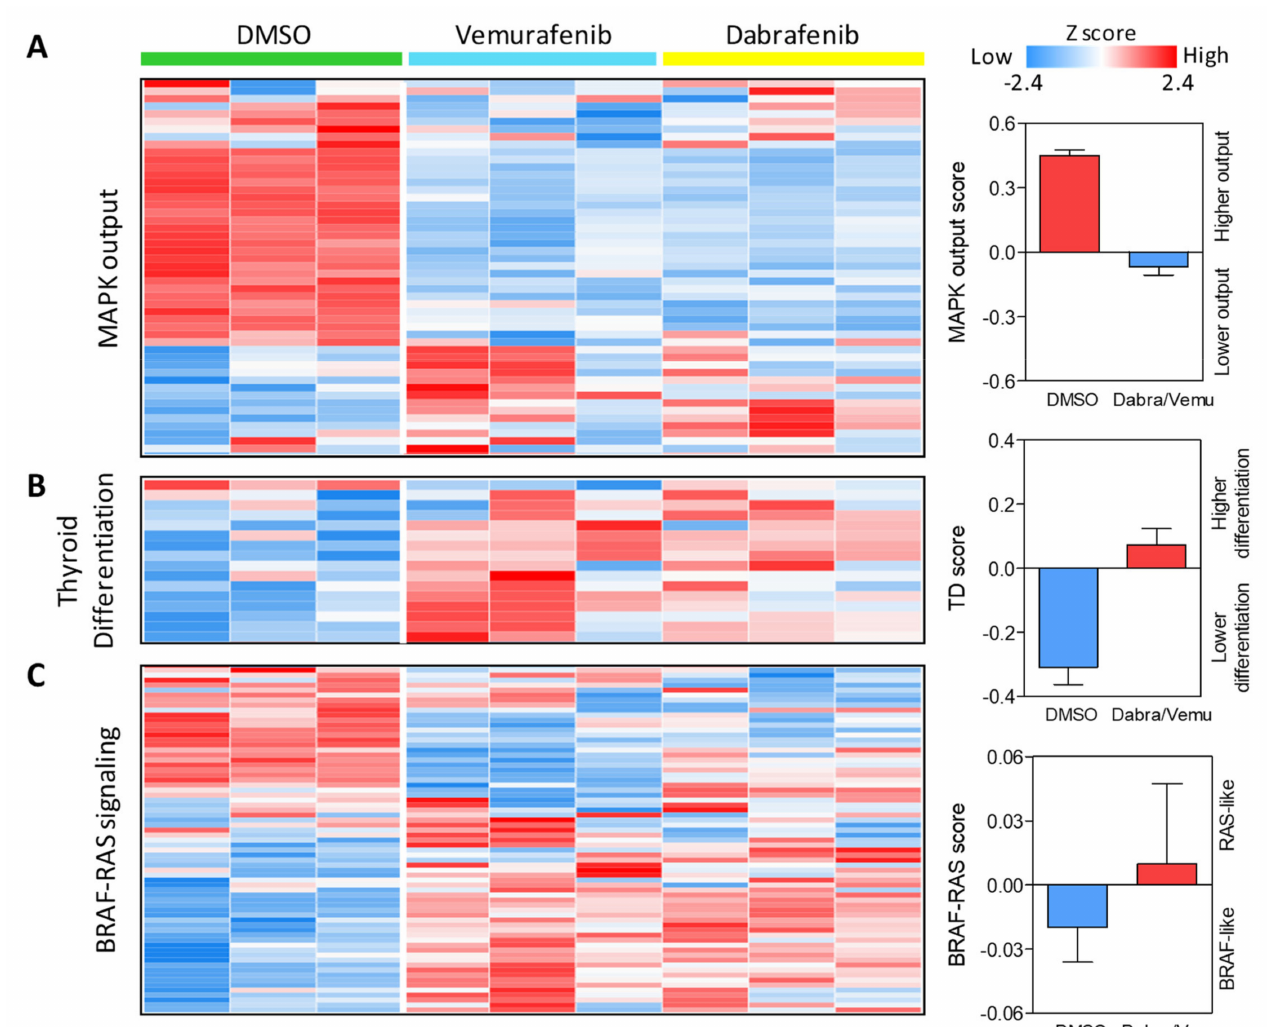
Figure 5. Expression of thyroid cancer related gene signatures in BRAF inhibitor treated BCPAP cells. ( A ) Gene signature related to the activation status of MAPK pathway (MAPK output). ( B ) Gene signature related to thyroid differentiation. ( C ) Gene signature related to BRAF-RAS signaling. The 3 gene signatures are derived from TCGA, lists available in Supplementary Table S2. Heatmaps show the expression of the genes included in each signature across control (DMSO) and BRAF inhibitor (Vemurafenib or Dabrafenib) treated cells in 3 technical replicates per condition. On the right, the corresponding expression score (see Materials and methods for score